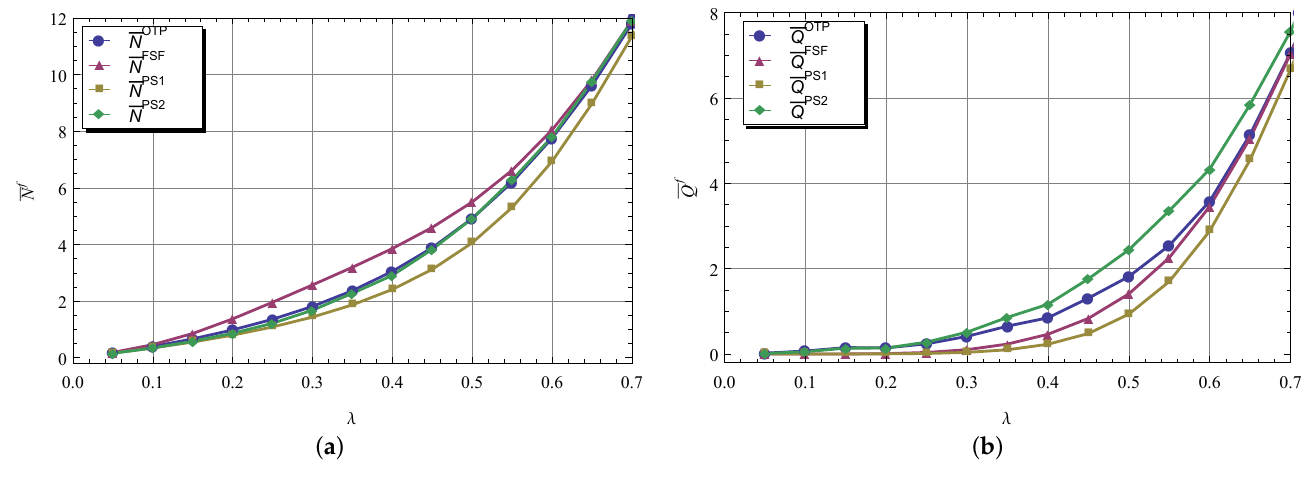
Figure 3. ¯ N f ( a ) and ¯ Q f ( b ) versus λ . Figure 4 illustrates the influence of λ and model types on the functions ¯ C f (figure labelled by “a”) and ¯ L f (figure labelled by “b”). The functions of the mean number of busy servers for the OTP- and PS1-models are very close to each other. Thus, by subtracting the mean number of busy servers in PS1-model from the mean number of customers in PS2-model, an approximation can be obtained for the mean queue length of the OTP-model. The functions ¯ C FSF and ¯ C PS 2 represent the upper and low bound for ¯ C OTP . The longest busy period appears in FSF-model. In this case the slower servers can be occupied with higher probability and then these servers remain busy for a very long time. As expected, the shortest busy period exhibits the preemptive PS1-model.